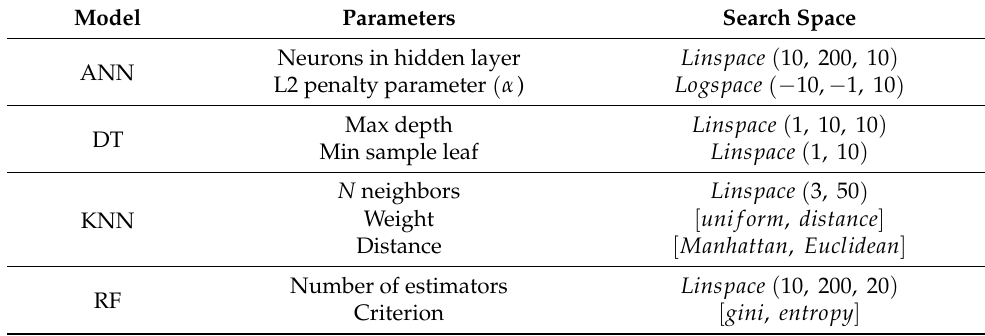
Table 3. Hyperparameter search spaces of the